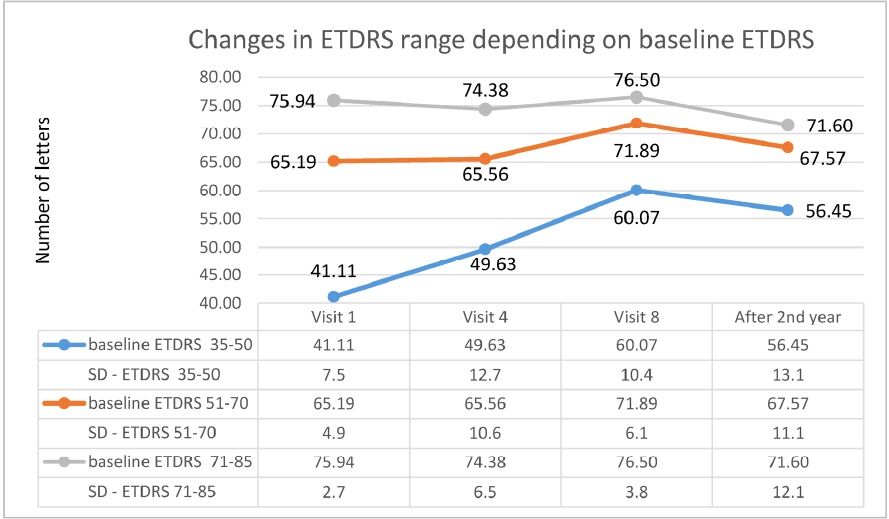
Figure 5. Changes in best corrected visual acuity in the ETDRS during individual follow-up visits in groups based on initial visual acuity—data for Aflibercept.